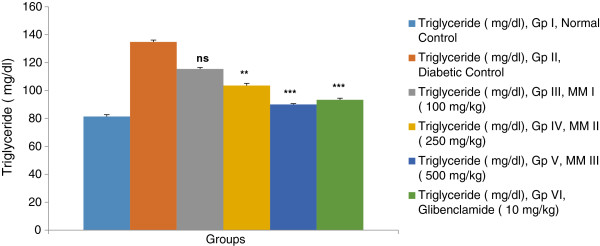
Effect of Melastoma malabathricum Linn. (MM) on level of triglyceride at different concentrations on STZ induced diabetic rats, compared to standard drug Glibenclamide; values are mean ± SEM; n = 6; *P < 0.05; **P < 0.01; ***P < 0.001; P > 0.05 is considered as non-significant (ns).